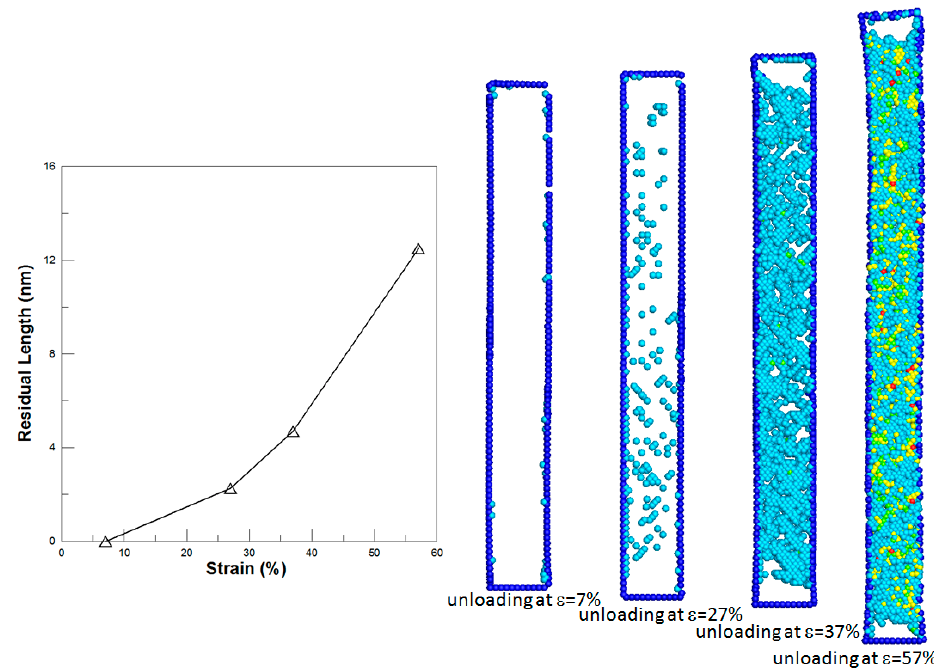
Figure 17. Residual length and residual phases after unloading. (blue: incomplete nanostructure with CN < 4; cyan: CN = 5 meta-stable phase with CN = 5; yellow: Si-II phase with CN = 6; red: high pressure phase with CN > 6).